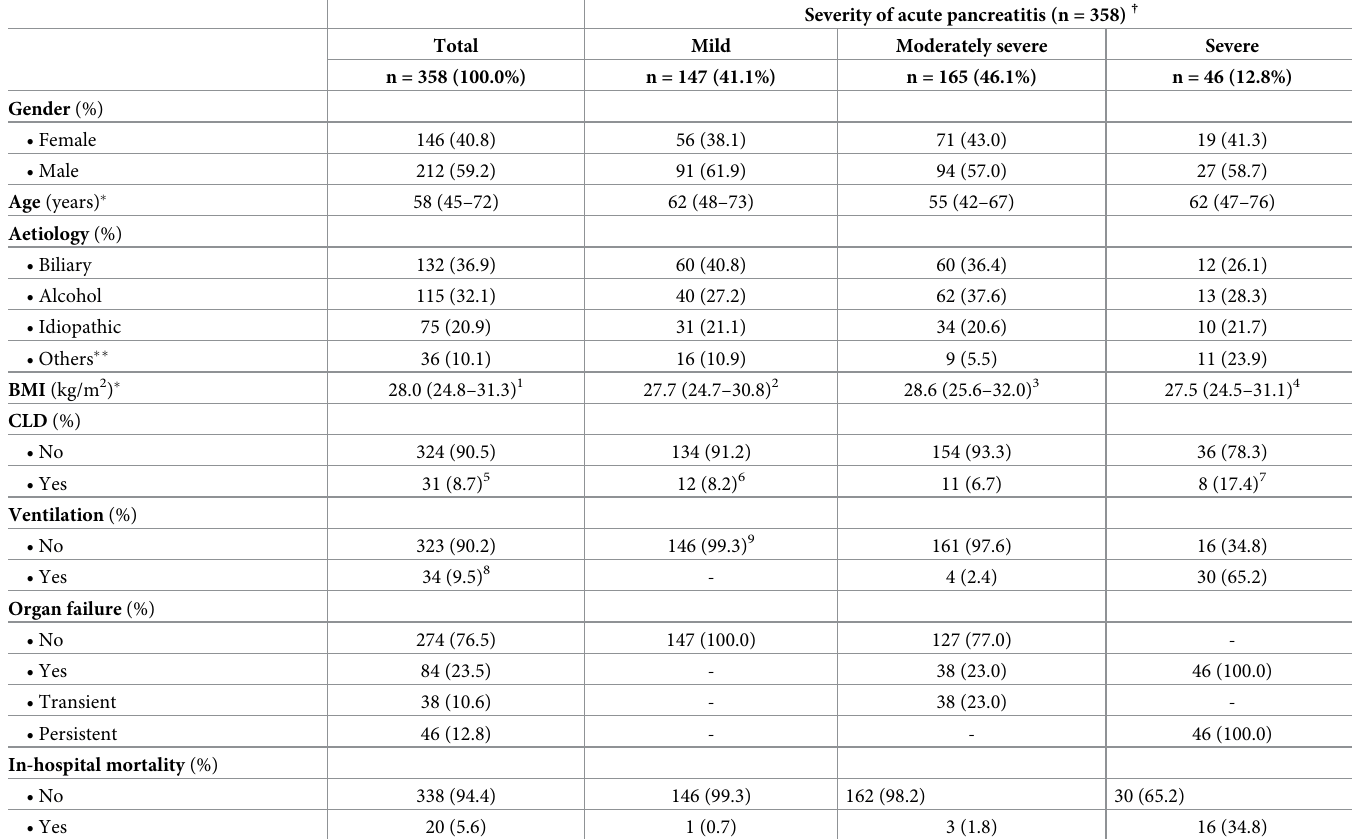
Table 1. Baseline characteristics of the study population (n =